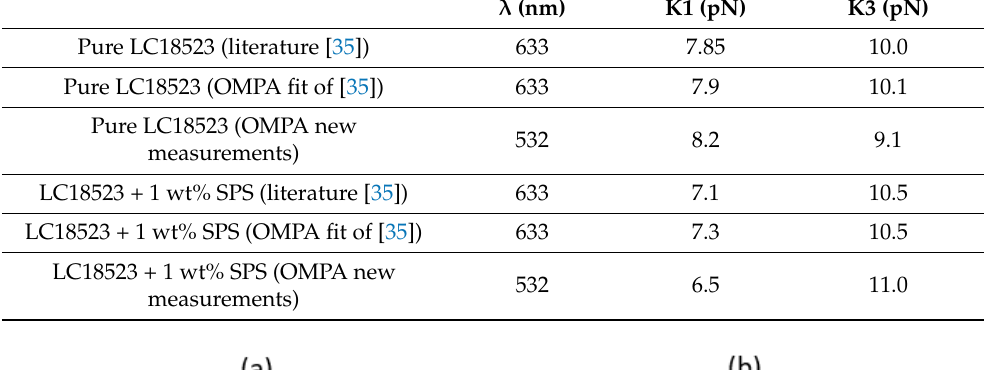
Table 2. Summary of elastic constants obtained by the OMPA through the fitting of CPIs from cells filled with pure and nanoparticle-doped LC18523. These cells were measured using light illumination at 633 nm and 532 nm.